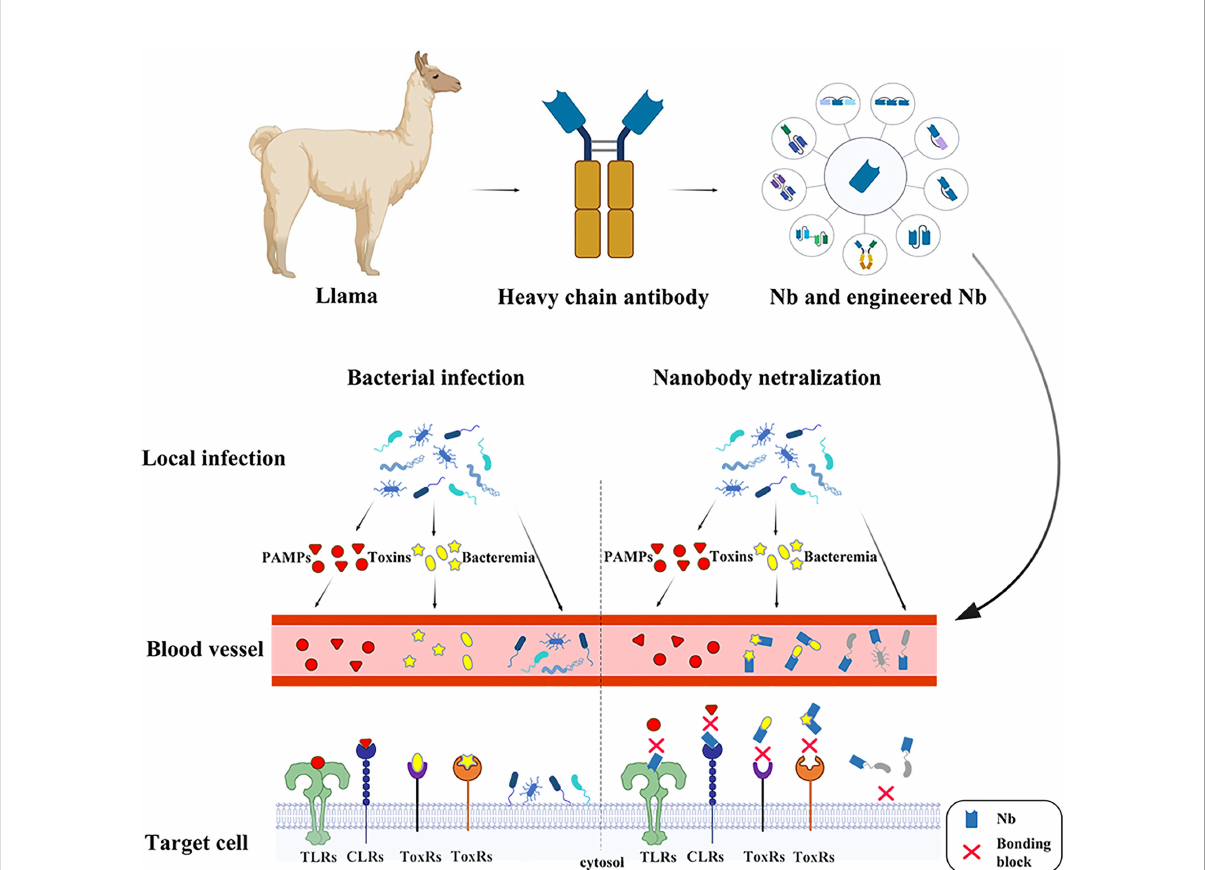
FIGURE 1 The nanobodies take effects in several ways against bacterial infection. In the early stage of infection, pathogenic microorganisms are con fi ned to the lesion. At this time, the PAMPs and the toxins are released into the bloodstream. The nanobodies binding onto the receptors prevent PAMPs recognition by PRRs, such as Toll-like receptors, Nod-like receptors and C-type lectins such as Clec4f, leading to a series of bodily reactions. The toxins, such as CDT, Tcd and BoNT are the major part in bacterial pathogenicity, which serve in different ways to cause damage in hosts and assist in enlargement of infection foci. The neutralizing nanobodies protect the host through speci fi cally binding the toxins. At late stage of infection, pathogens are released into blood causing bacteremia. The nanobodies recognizing surface antigens, such as pilus and fl agellum, bind onto the pathogen surface, preventing bacterial